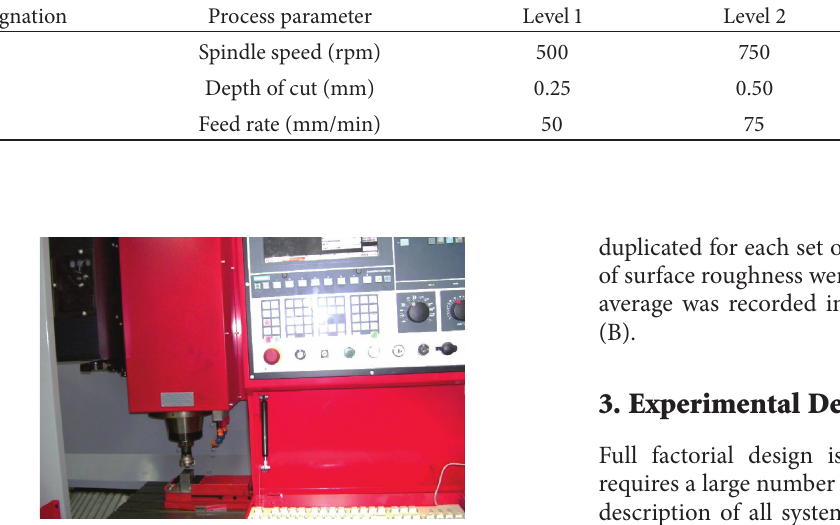
Figure 1: Test rig for machining the workpieces.